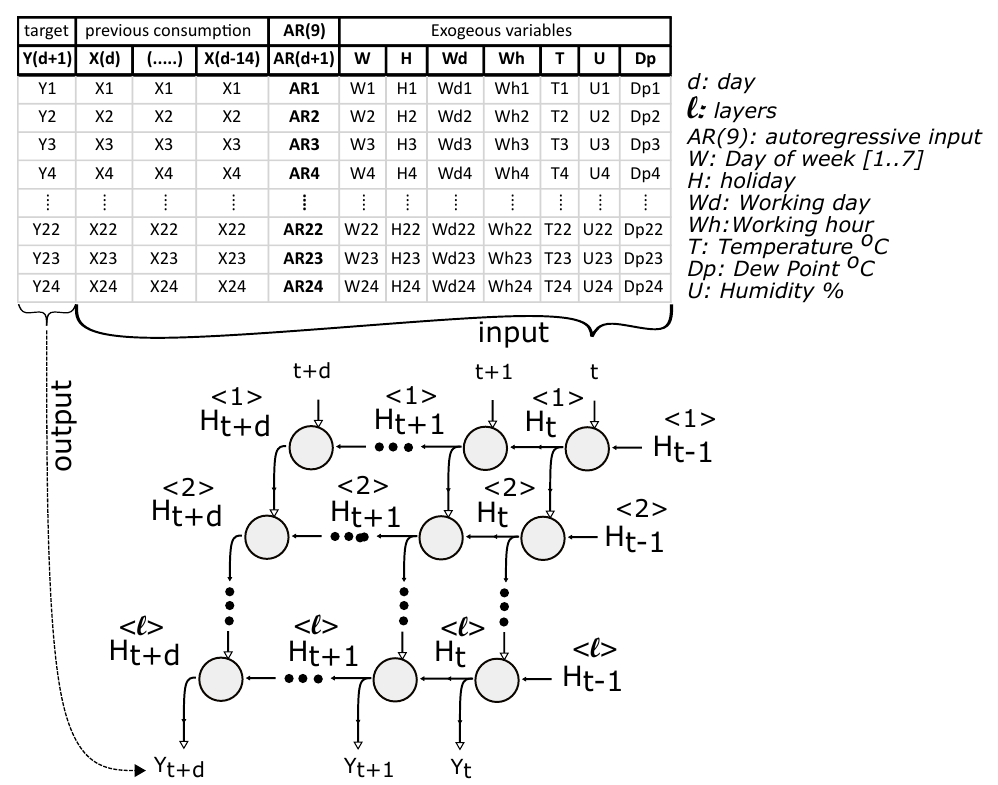
Figure 5. The proposed framework for the implementation of deep learning for hourly load curves.